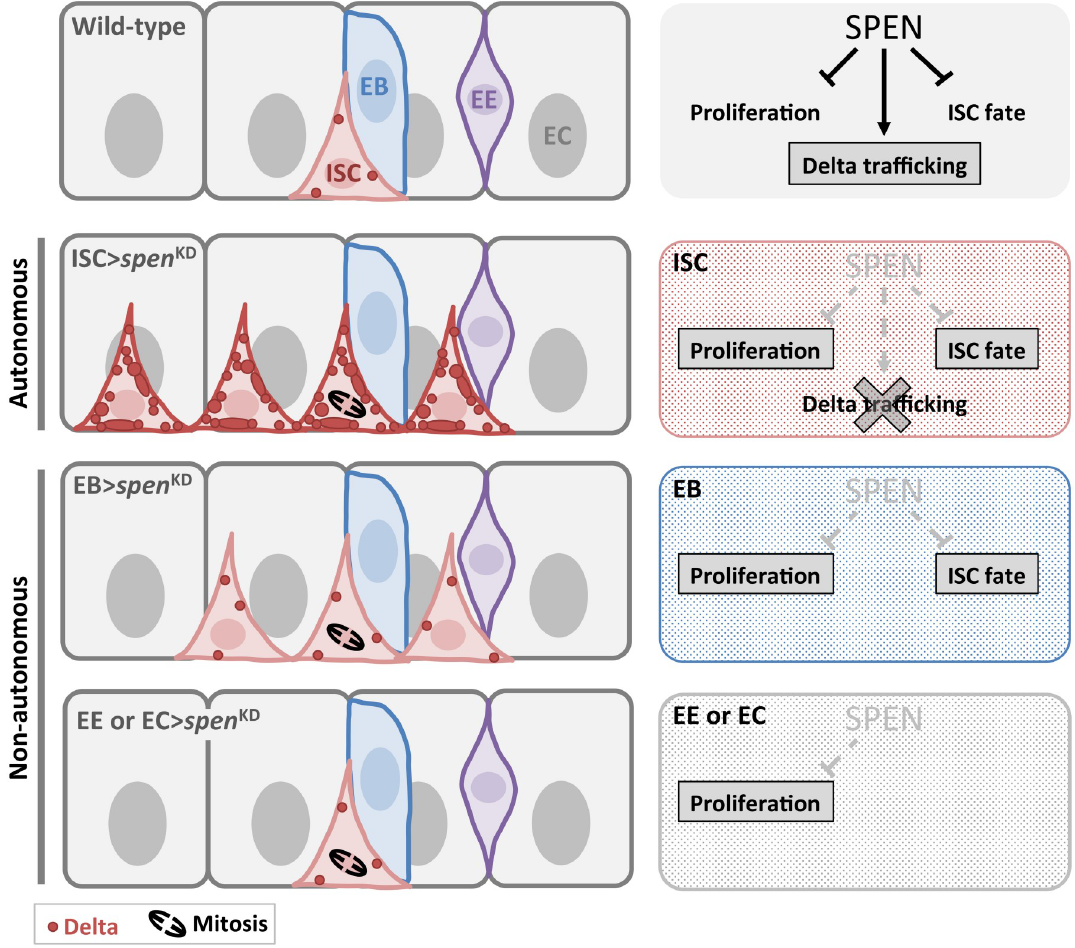
Fig 7. Model. Autonomous and non-autonomous roles of spen in the control of intestinal stem cells. In the intestinal stem cell (ISC), spen acts autonomously to limit their proliferation and stem cell self-renewal. Its inhibition leads to an accumulation of the Delta protein at the membrane. This is likely due to an effect on Dl trafficking, which may be direct or indirect. spen also acts in a non- autonomous manner in the Enteroblast (EB) to limit ISC numbers. Furthermore, spen inactivation in EBs, Enteroendocrine cells (EE) and Enterocytes (EC) leads to enhanced ISC proliferation. Further studies will be required to better understand Spen’s molecular